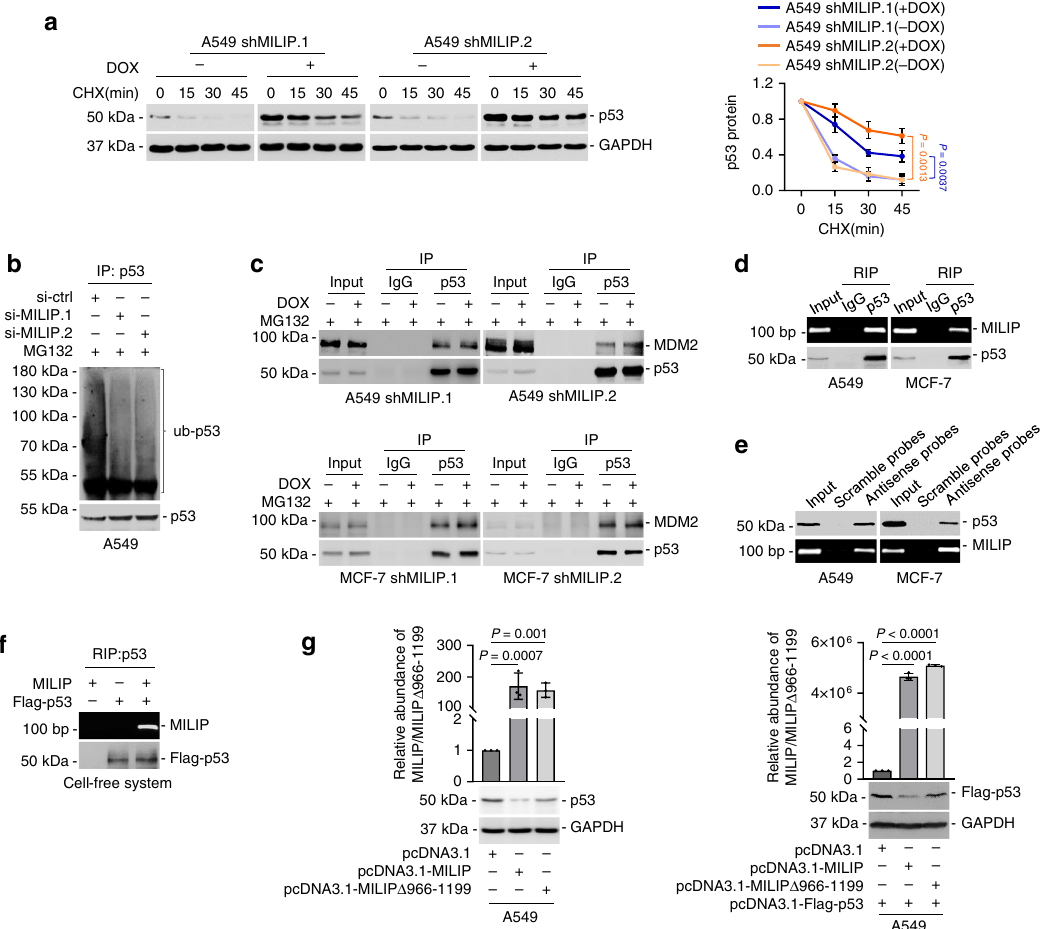
Fig. 3 MILIP binds to and destabilizes p53. a Induced knockdown of MILIP prolonged the half-life time of p53 protein in cycloheximide (CHX)-chase assays. Data are representatives or mean ± s.d.; n = 3 independent experiments, two-tailed Student ’ s t test. CHX: 40 µ g/mL, DOX: 200 ng/mL. b MILIP silencing reduced p53 polyubiquitination. Data shown represent three independent experiments. c Induced knockdown of MILIP did not reduce the binding between p53 and MDM2. Data shown represent three independent experiments. d MILIP was coprecipitated with p53 using RNA immunoprecipitation (RIP) assays. Data shown represent three independent experiments. e p53 was co-pulled down with MILIP by antisense probes against MILIP using RNA pulldown assays. Data shown represent three independent experiments. f In vitro transcribed MILIP was coprecipitated with puri fi ed Flag-tagged p53 in a cell-free system using RNA immunoprecipitation (RIP) assays. Data shown represent three independent experiments. g Overexpression of MILIP but not a MILIP mutant with the − 966/ − 1199 segment deleted (MILIP Δ − 966/ − 1199) downregulated both endogenous (left) and overexpressed exogenous (right) p53 protein levels. Data are mean ± s.d.; n = 3 independent experiments, one-way ANOVA followed by Tukey ’ s multiple comparisons test. Source data of Fig. 3a – g are provided as a Source Data fi